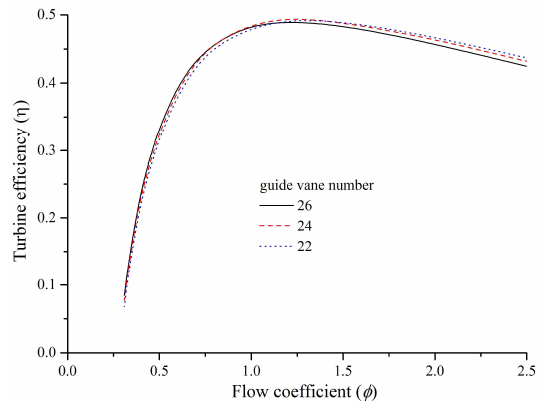
Figure 9. Influence of the number of guide vanes on the efficiency.